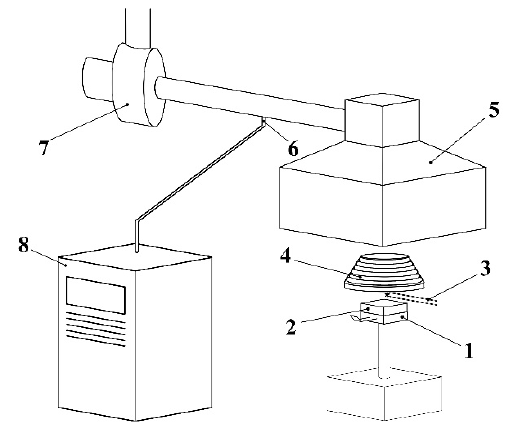
Figure 2. The schematic of the cone calorimeter: 1—sample holder, 2—sample, 3—initiator, 4—cone heater, 5—exhaust hood, 6—combustion gas sample extraction, 7—fan, 8—combustion gas analyser. The fan flow rate was set to 0.024 ± 0.002 m 3 s − 1 , ambient temperature ranged from 22 ◦ C to 27 ◦ C and the relative humidity of air was 20–27%. The atmospheric pressure was between 100.92–101.91 kPa. Measurements were performed at heat fluxes of 20 kW m − 2